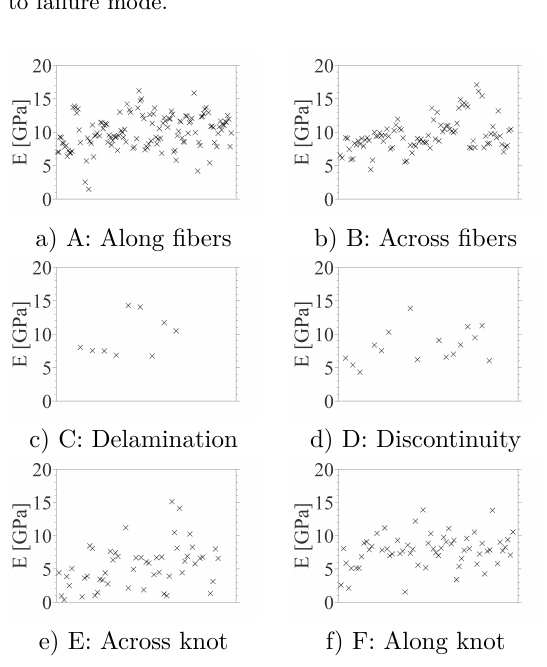
Figure 3. Young’s moduli ( E [GPa]) from tensile test for individual failure